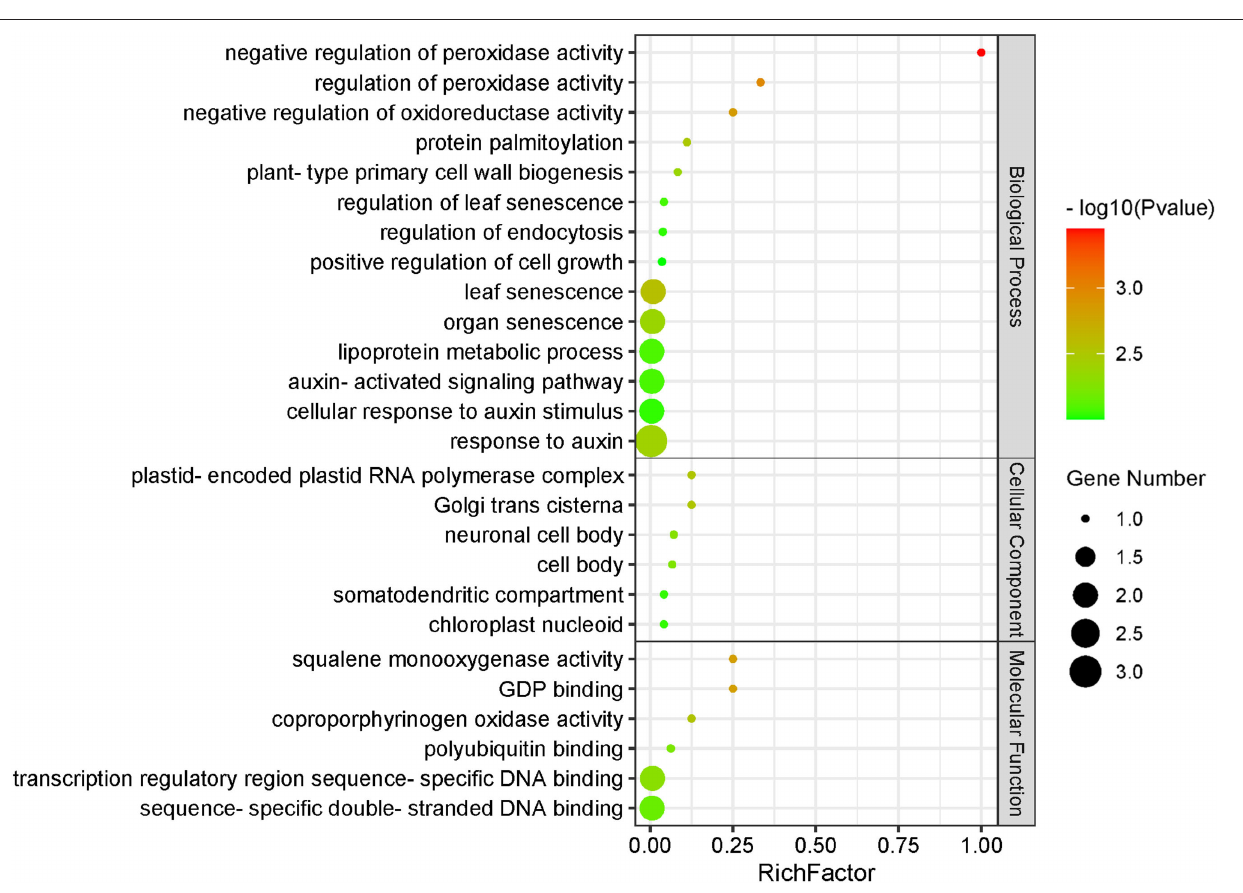
2, which were involved in peroxidase activity, senescence, and the auxin-related biological process, respectively ( Figure 5